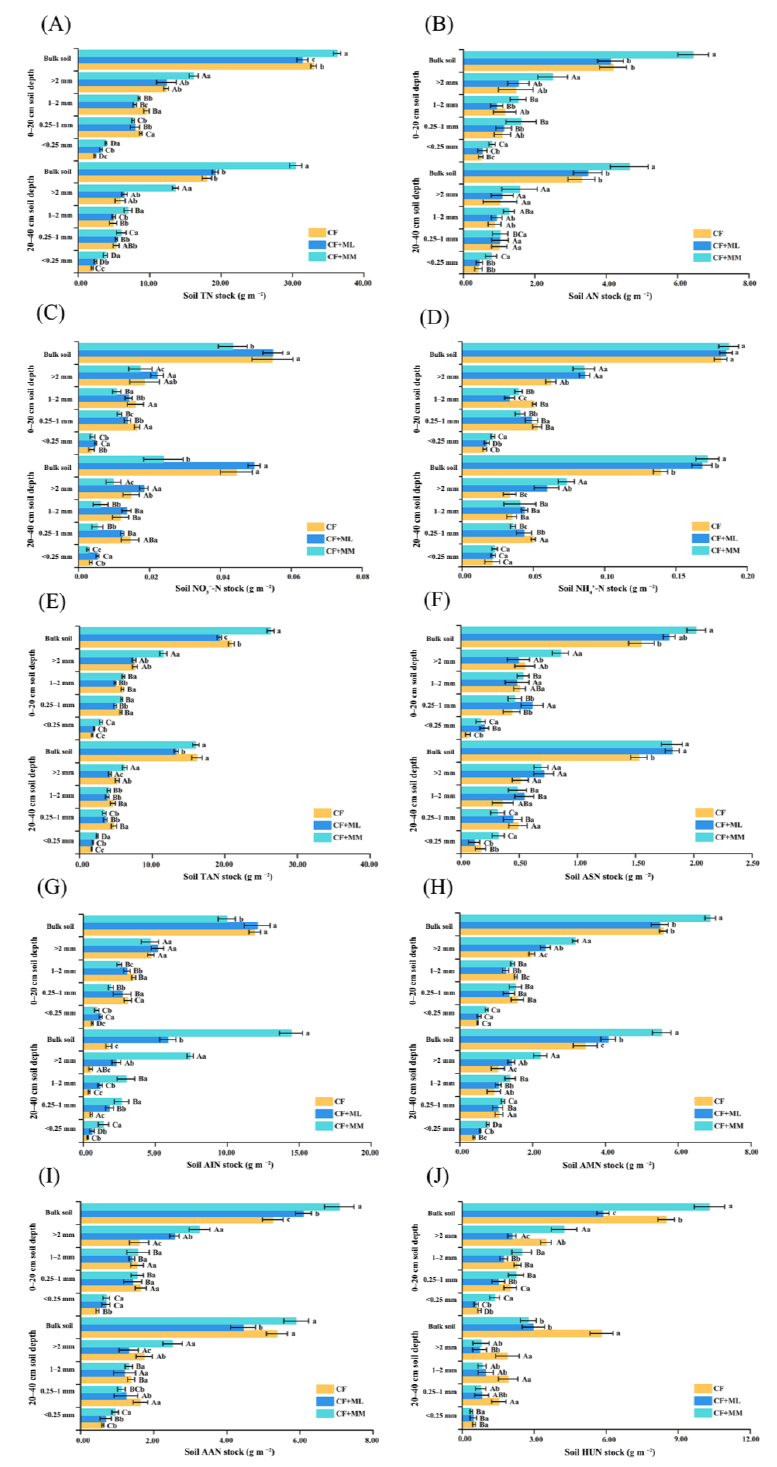
Figure 4. Soil total nitrogen (TN), available nitrogen (AN), nitrate nitrogen (NO 3 − -N), ammonium nitrogen (NH 4+ -N), total acidolysable nitrogen (TAN), amino sugar nitrogen (ASN), nonacidolyzable nitrogen (AIN), cidolyzable ammonia nitrogen (AMN), amino acid nitrogen (AAN), and unknown acidizable nitrogen (NUN) stocks within aggregate size in Chinese fir plantations with different stand types in 0–20 and 20–40 cm ( A – J ) soil depth. Different capital letters stand for significant differences ( p < 0.05) among different aggregate sizes in the same forest types. Different lowercase letters represent significant differences ( p < 0.05) among different stand types with the same